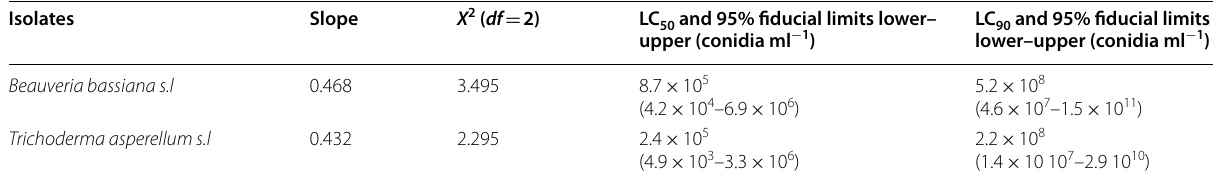
Table 4 LC and LC values of the two selected entomopathogenic fungus isolates against 2 nd instar larvae of Spodoptera frugiperda 50 90 at 10-day post-treatment